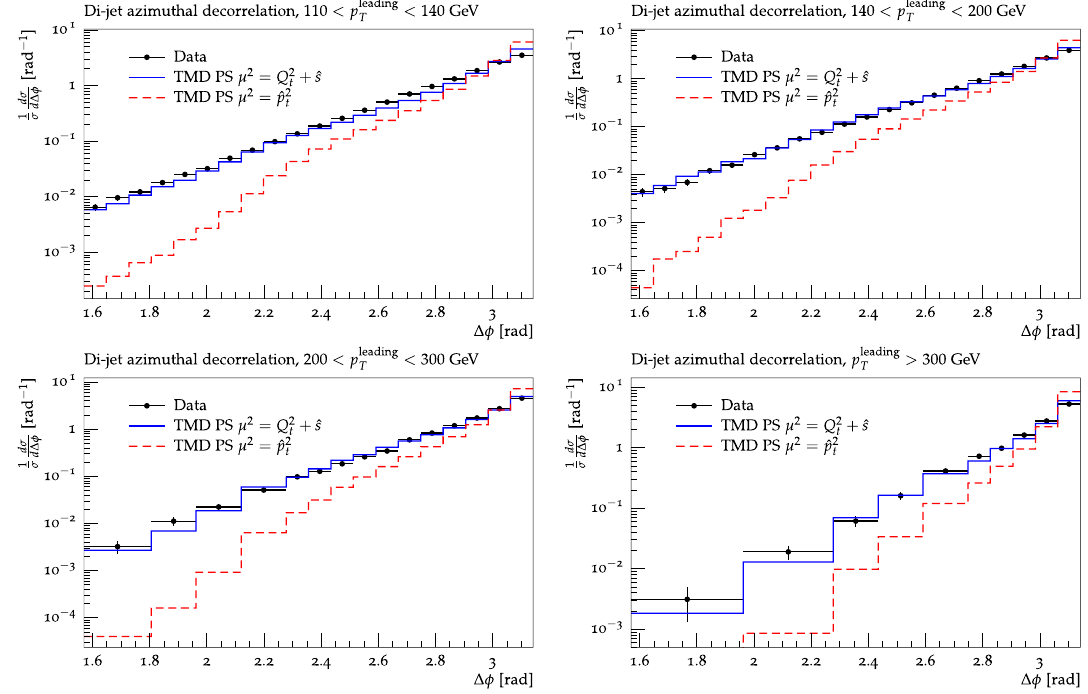
ton shower, conventional final state parton shower and hadronization. Shown are predictions for two different choices of the factorization scale, as discussed in the